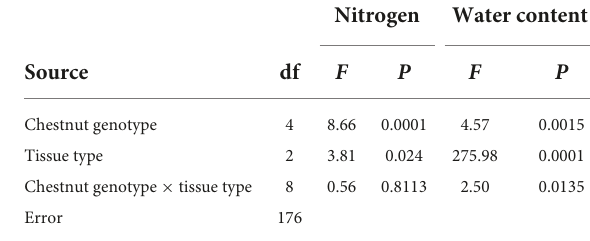
TABLE 3 ANOVA results testing for patterns in nitrogen and water content of three tissue types (ungalled leaf, gall, ungalled portion of galled leaf) in each of the five genotypes with galls (three species, the susceptible hybrids and resistant hybrids Type